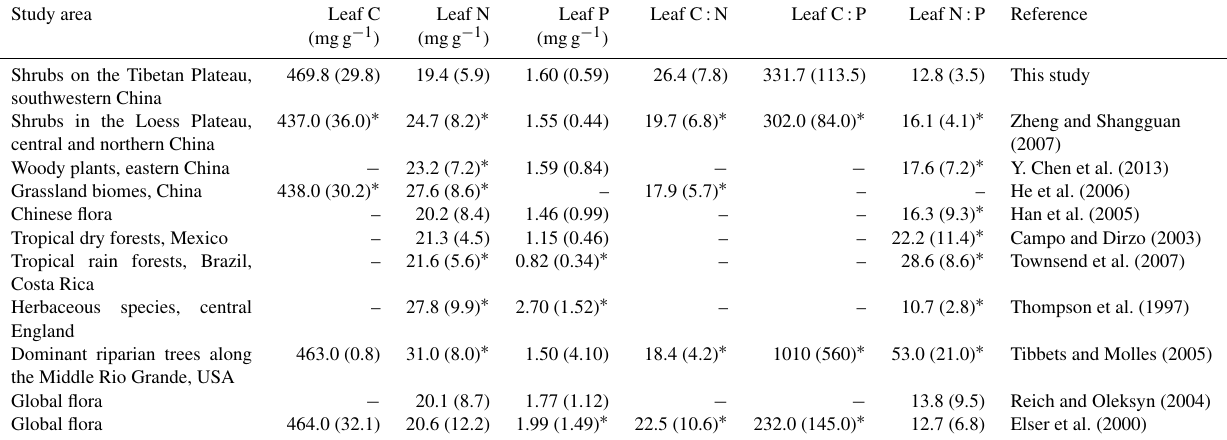
Table 3. Comparison of arithmetic means of leaf C, N, P and C:N:P ratios between the shrubs on the Tibetan Plateau and other regional or global plants using the Kruskal–Wallis test followed by pairwise comparisons. Standard deviations are in parentheses. Study